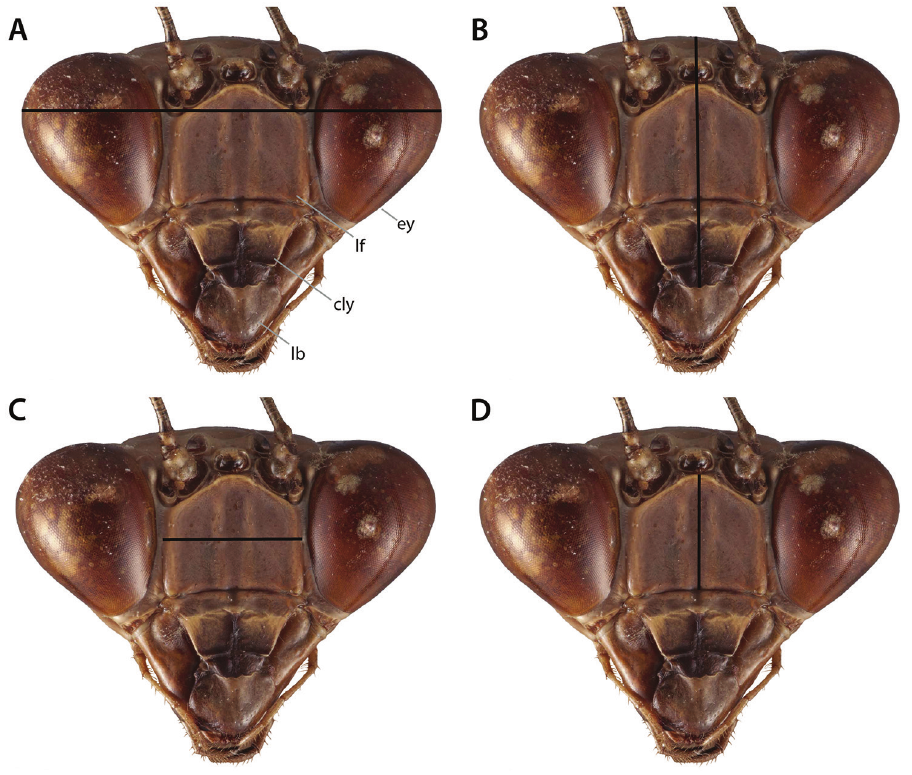
Figure 24. Head and lower frons measurement standards. Solid black lines indicate approximate location to take length and width measurements. Sphodromantis sp. head A head width B head length C lower frons width D lower frons length. Abbreviations: cly = clypeus; ey = compound eye; lb = labrum; lf = lower